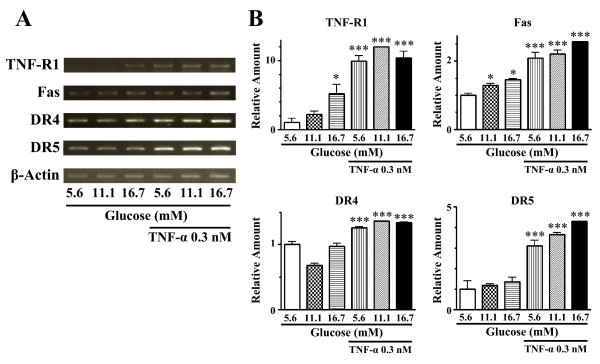
Abilities of high glucose (11.1 and 16.7 mM) and TNF-α (0.3 nM) to up-regulate gene expression levels of death receptors in HCAECs. The mRNA levels of TNF-R1, Fas, DR4, and DR5 were analyzed by RT-PCR (A) and real-time PCR (B). Actin was used as a reference gene for normalization of quantitative real-time PCR. Values are expressed as mean ± SE (n = 3). *P < 0.05, **P < 0.01, ***P < 0.001 versus normal glucose (5.6 mM) without TNF-α.